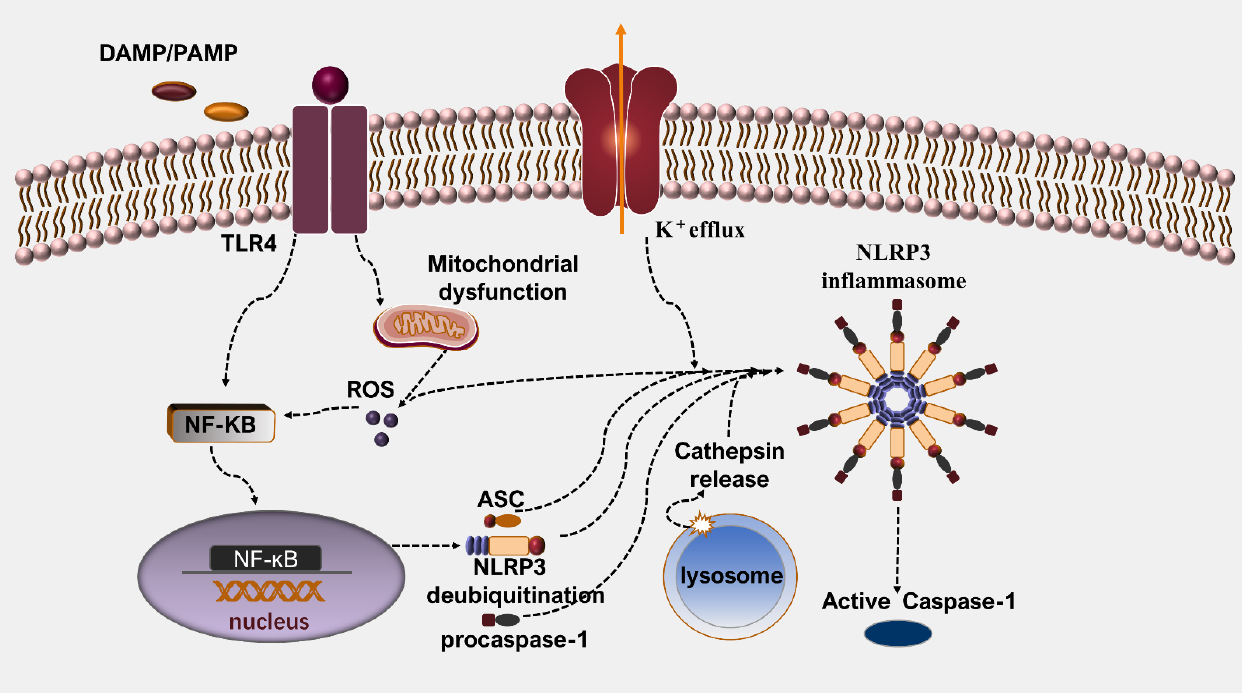
Figure 1. The mechanism of NLRP3 inflammasome activation. The process of activation contains two phases: priming and activating. In the priming phase, DAMP or PAMP induces the activation of NF ‐κ B signal and triggers an increase in NLRP3 expression. Additionally, NLRP3 deubiquitnation, the adaptor molecule ASC, and procaspase ‐ 1 together accomplish the assembly of inflammasome. In the activating phase, several distinct stimuli signals are required to activate NLRP3 inflammasomes, such as mitochondrial ROS, K + efflux, and cathepsins released by lysosome.